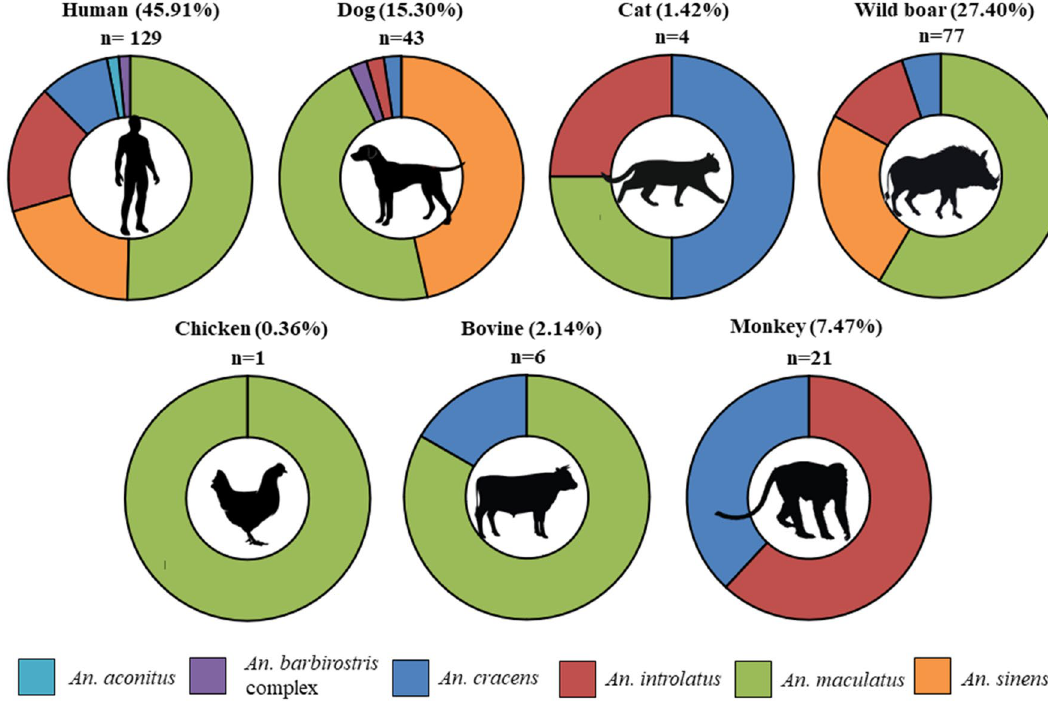
Figure 5. Proportion of host preference by Anopheles species.